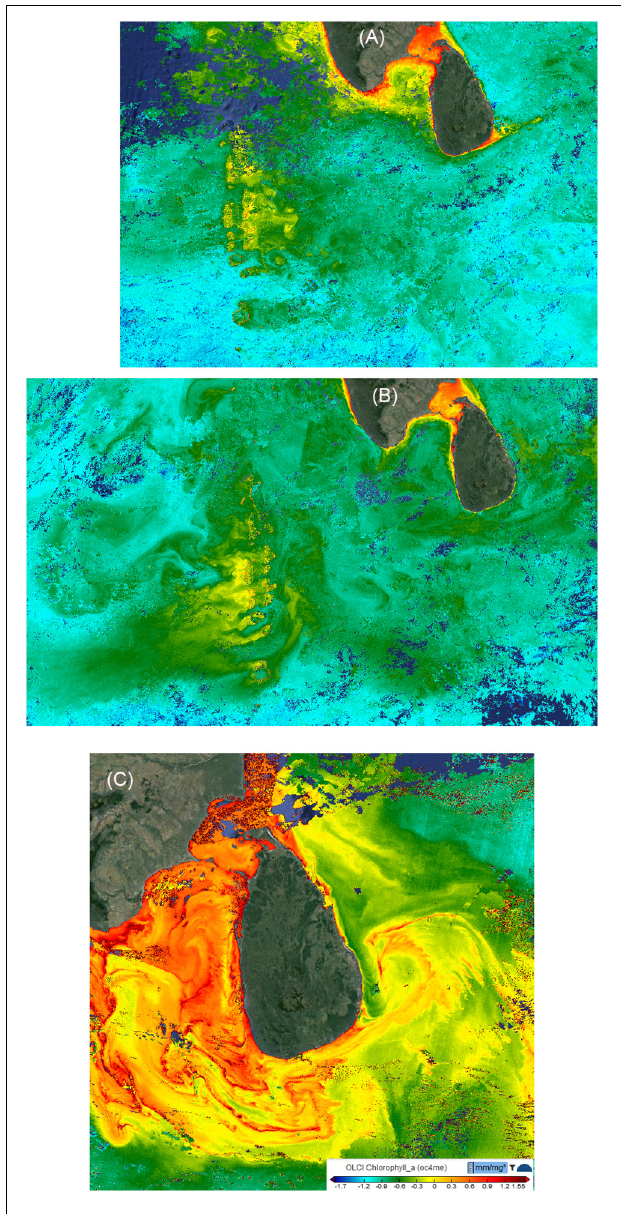
FIGURE 2 | Surface chlorophyll concentrations (SCC) obtained from the Sentinel-3 satellite. (A) SWM; 7-day mean 9–15 June 2020; (B) NEM; 7-day mean 1–7 February 2020; (C) SWM; 3-day mean 10–12 August 2020. The images were sourced from https://s3view.oceandatalab.com/ and display SCC estimated using the oc4me algorithm (Morel et al., 2007).